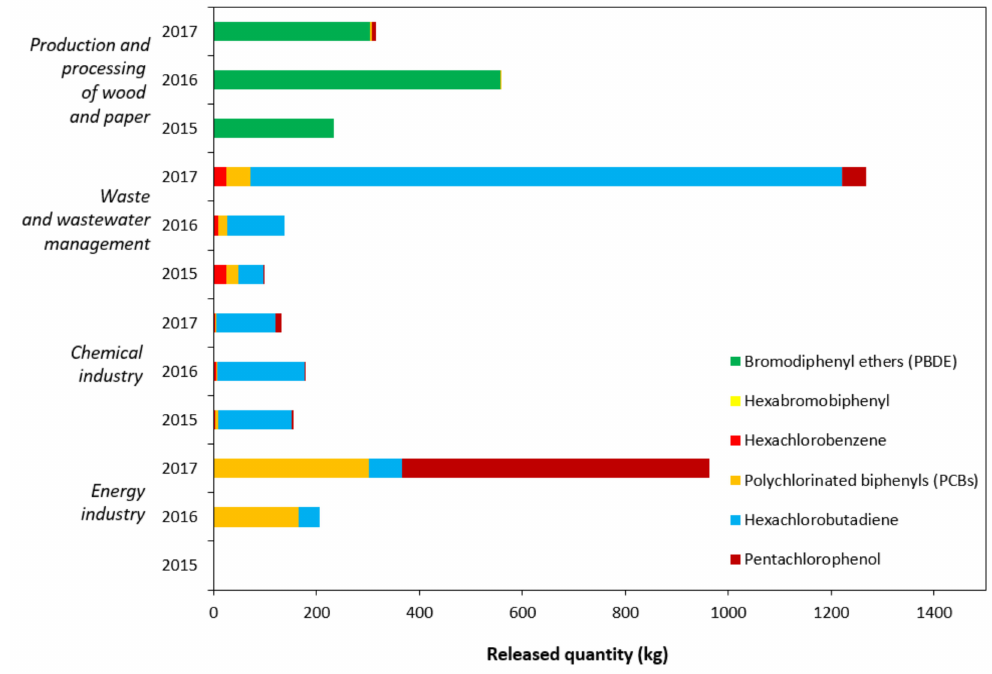
Figure 4. Emissions of industrial chemicals and by-products from various industrial activities in Europe’s surface waters in the period